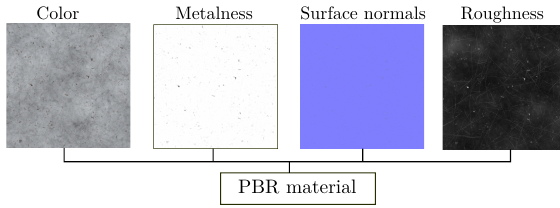
Figure 4: Cycles and Luxcore comparison. The Lux- core rendering is able to simulate more real- istic reflections.